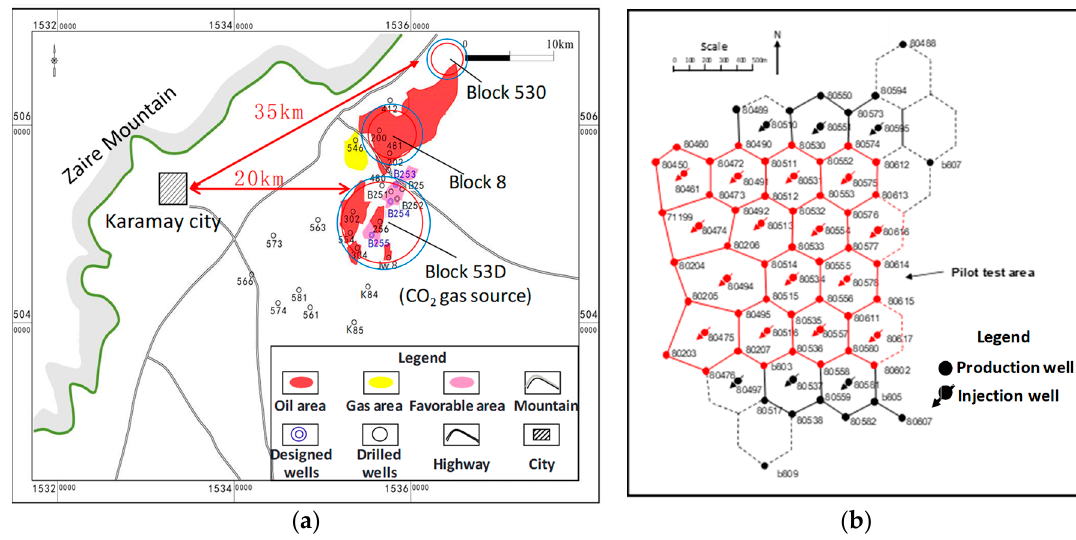
Figure 1. ( a ) The location of block 530 ( b ) Well groups selected in the block 530.The block 530 and well groups selected for CO 2 EOR and storage pilot project.